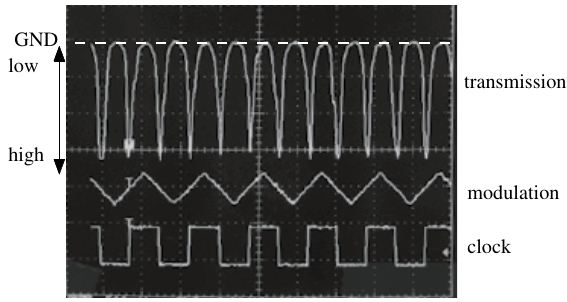
FIG. 3. Laser modulation. The transmitted laser intensity (top), the modulation signal fed into the piezoactuator (middle), and the basic clock signal